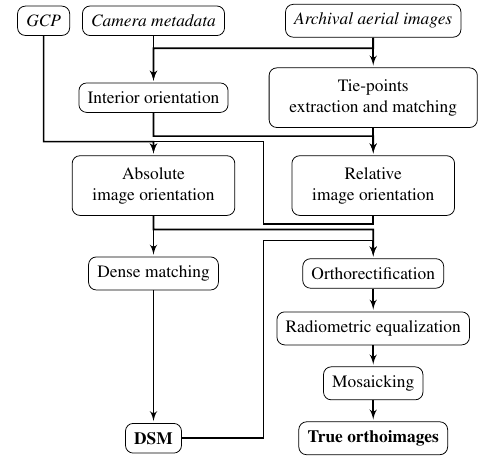
Figure 2. Standard photogrammetric pipeline for archival image